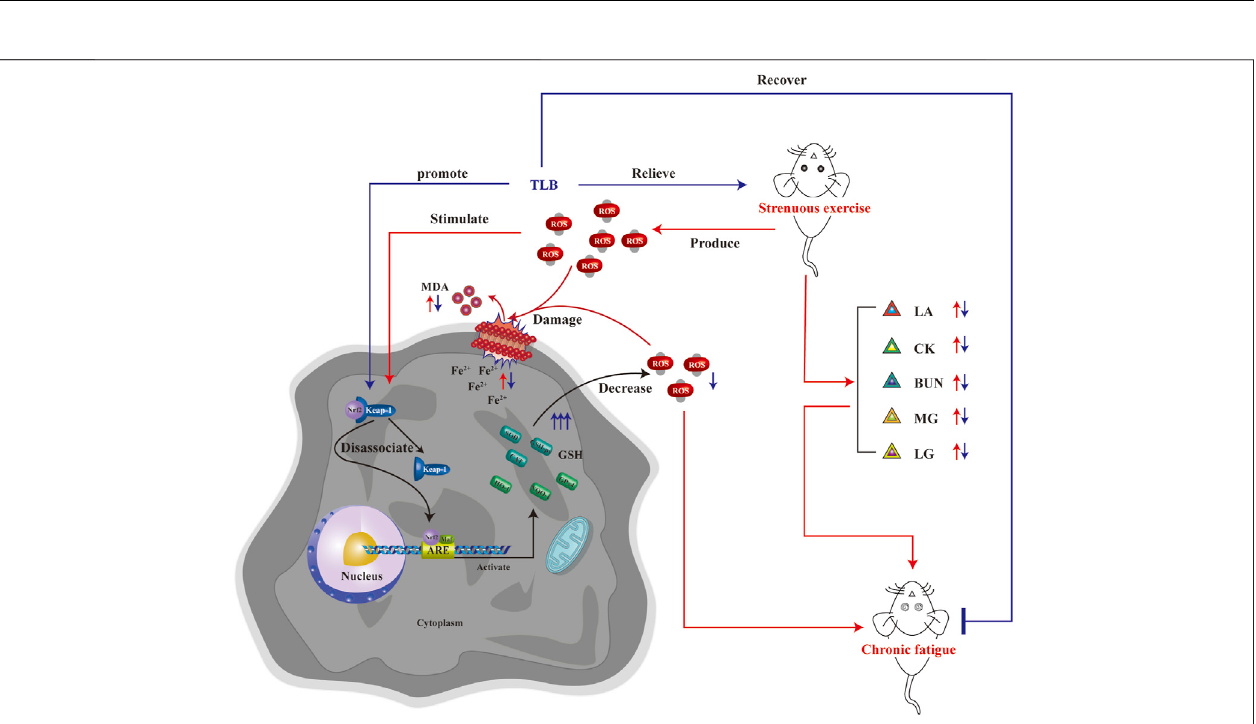
Frontiers in Pharmacology |